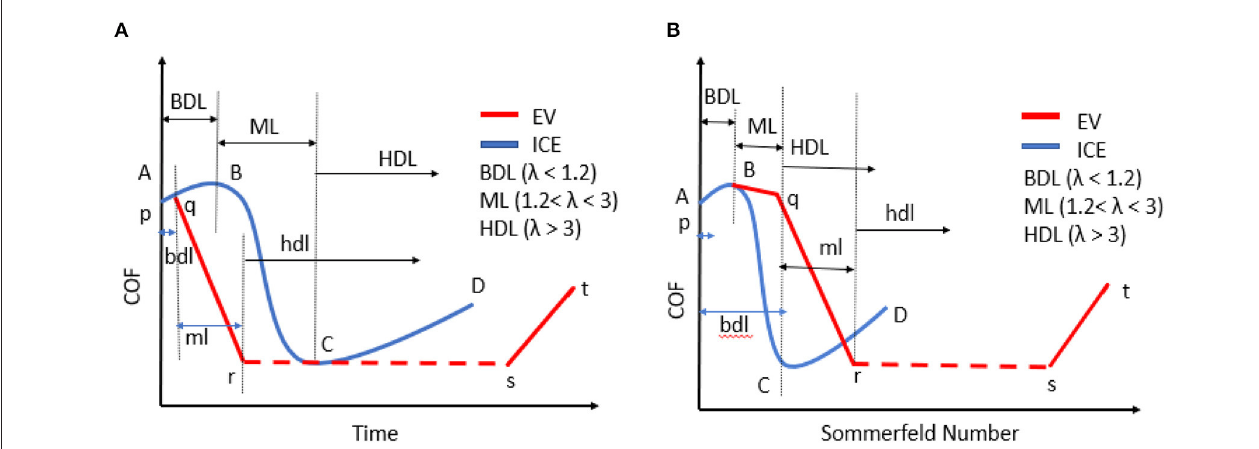
FIGURE 5 | A qualitative comparison of the frictional performance of EV and ICE. (A) is the COF against time and (B) the standard Stribeck curve plotted against Sommerfeld number. BDL, ML, and HDL refer to boundary lubrication, mixed lubrication, and hydrodynamic lubrication regimes, respectively. Small letters in the legend are provided for EV and capital letters for ICE. Each letter denotes a point. The parameter λ , where λ = t / r , t = film thickness and r = surface roughness, determines the lubrication regimes. Sommerfeld number is η V / P , where η = fluid viscosity, V = speed, P =